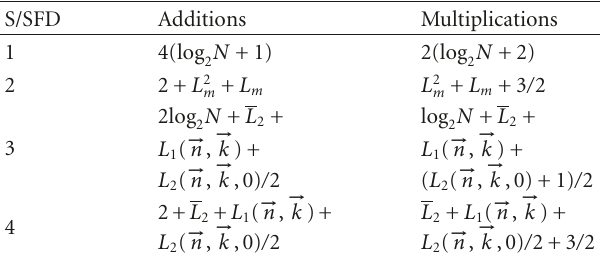
Table 1: Numbers of complex operations by frequency-frequency point required by the considered S/SFDs. (1) 2D WD (2) calculated using the FFT routines, (2) 2D SM using the recursive 2D STFT calculation (with 2 complex summations and a complex multipli- cation, [12]), (3) Proposed method with the 2D STFT calculation based on the FFT routines, (4) Proposed method using the recursive 2D STFT calculation, where L 2 ( the time needed for their execution is much smaller than the